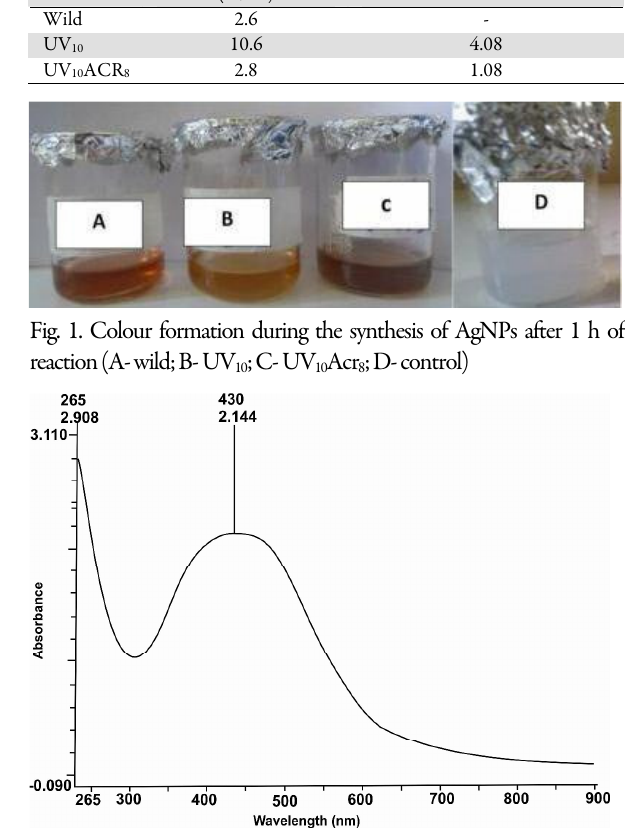
Table 1. Laccase activities of wild and mutant strains of L. edodes Strain